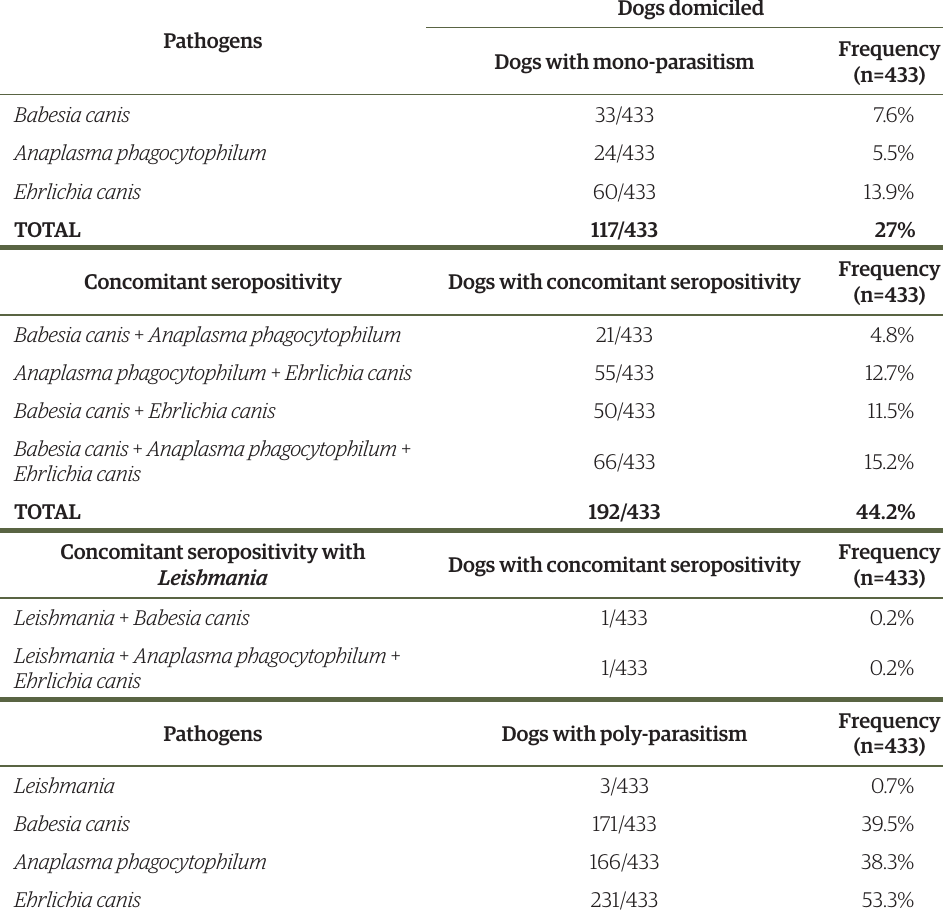
Tabela 1. Distribution of dogs evaluated for canine visceral leishmaniasis, babesiosis, ehrlichiosis, and anaplasmosis (mono-parasitism, concomitant seropositivity and poly-parasitism) in the municipality of Carmo da Mata, Minas Gerais State, Brazil,